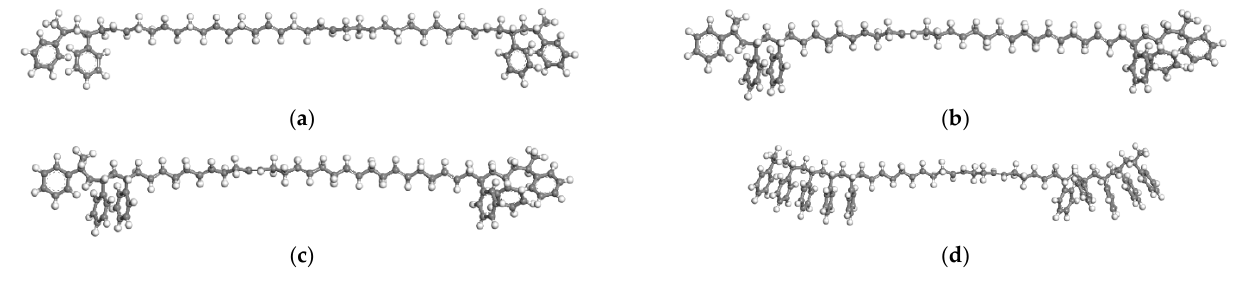
Figure 6. SBS molecular models with different block ratios. ( a ) 2/8. ( b ) 3/7. ( c ) 4/6. ( d ) 5/5.